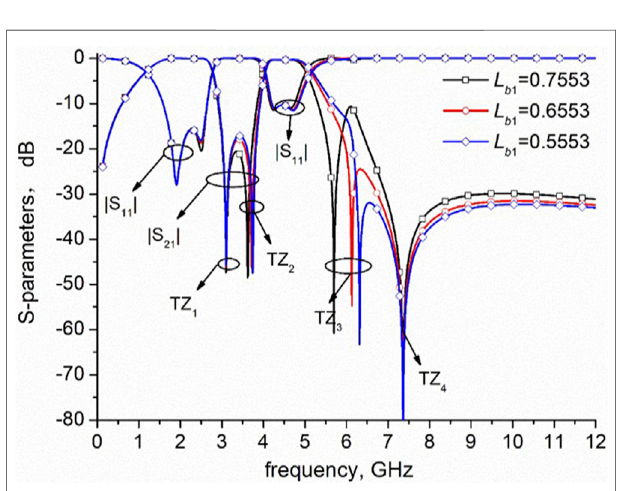
FIGURE 3 | Tunable TZ 2 and TZ 3 versus different L b 1 .